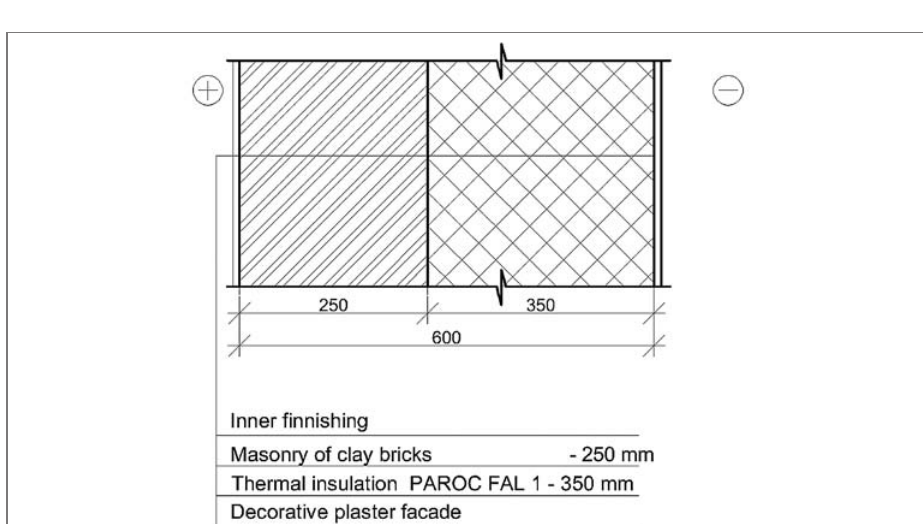
Floor: Floor on the ground is insulated with a 33 cm extruded polystyrene foam layer. The heat transfer coefficient of the floor is 0.12 W/m 2 K (normative value - 0.25 W/m 2 K). A design annual heat loss through the floor is 4.1 kWh/m 2 and it comes to 48.7 % of the heat loss of the same structure conforming to national